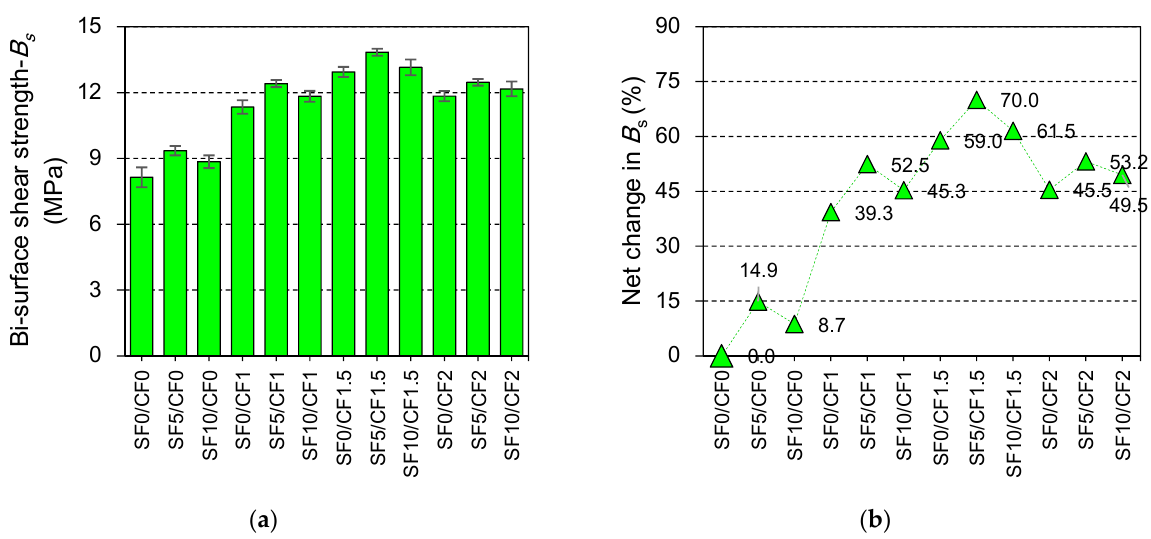
Figure 9. Effect of silica fume and coir incorporation on ( a ) 28 days’ bi-surface shear strength of HSC; ( b ) net change in the bi-surface shear strength of HSC compared to SF0/CF0.